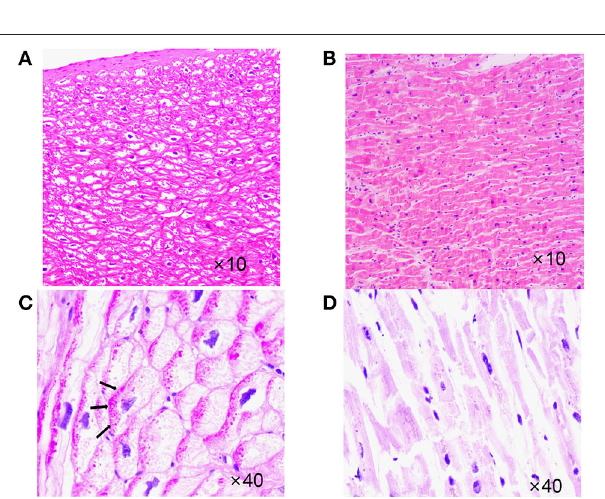
FIGURE 5 | Case 3 (III-7) vs. normal myocardial tissue. (A) Hematoxylin-eosin staining (HE staining),cardiomyocyte hypertrophy with large, malformed nuclei,some myocardial cells had vacuolated cytoplasm. (B) HE staining,Normal myocardial tissue. (C) Periodate-Scherff staining (PAS staining), red PAS staining-positive material in the cytoplasm of cardiomyocytes. Arrows indicate intracellular glycogen accumulation. (D) PAS